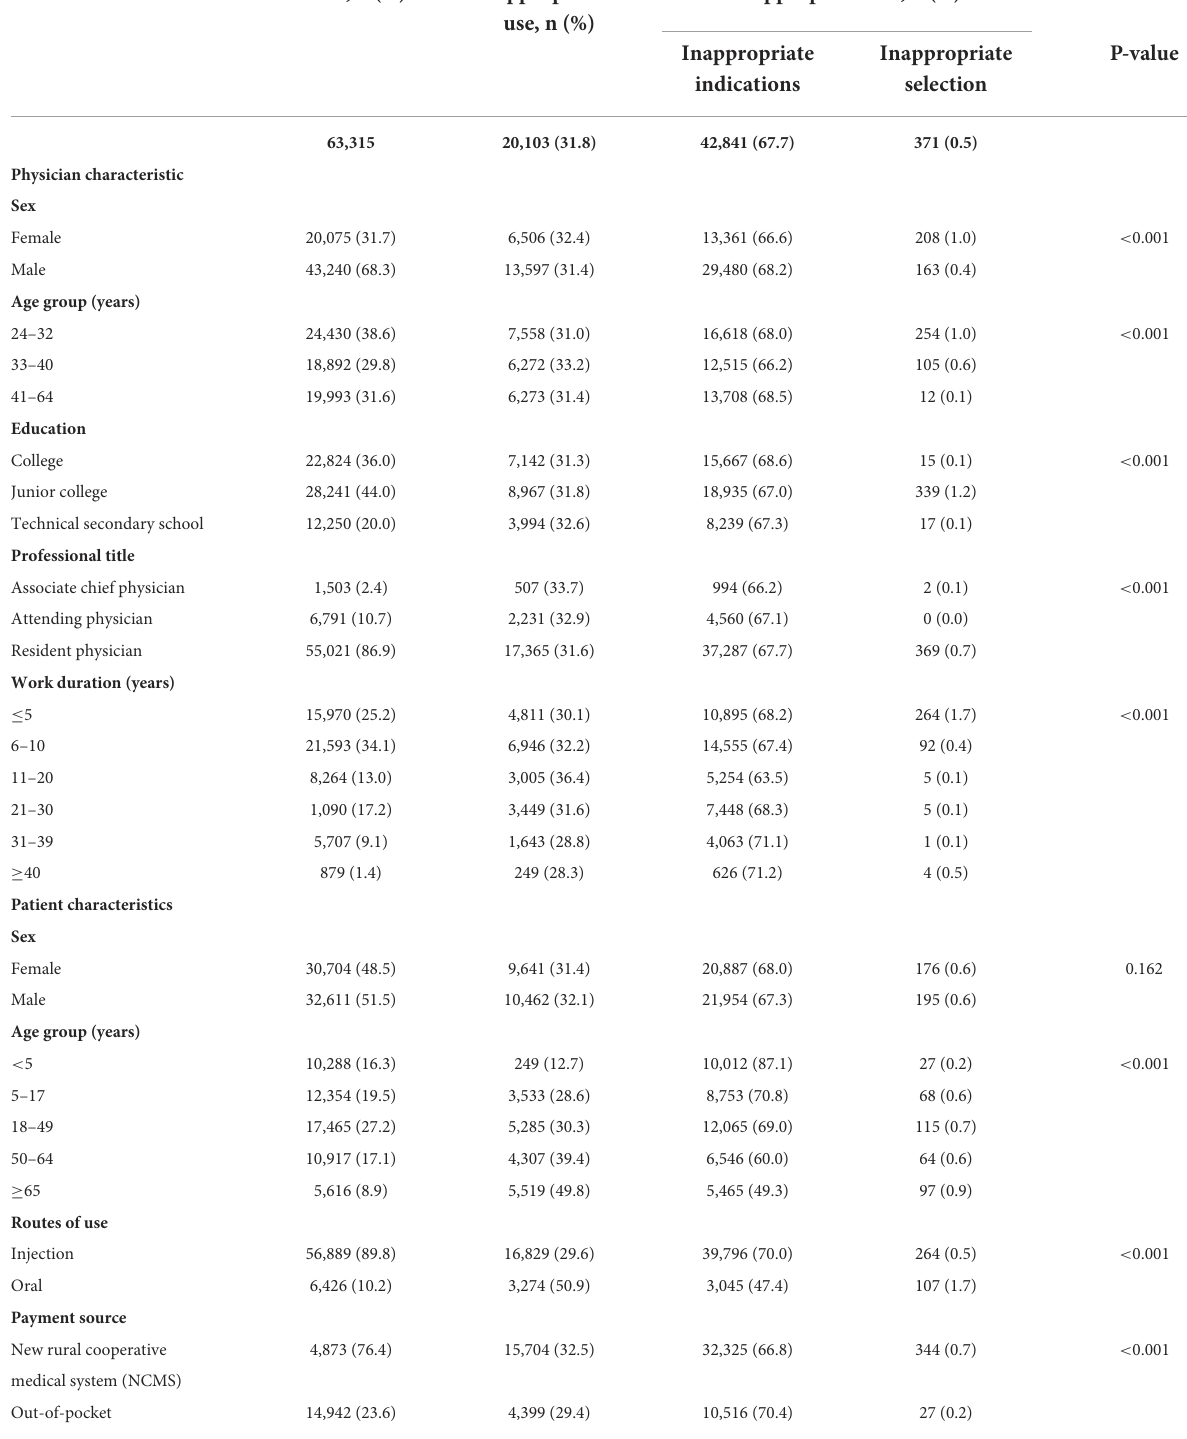
TABLE 2 Factors associated with inappropriate use of glucocorticoids on univariate analysis. Variables Total, n (%) Appropriate